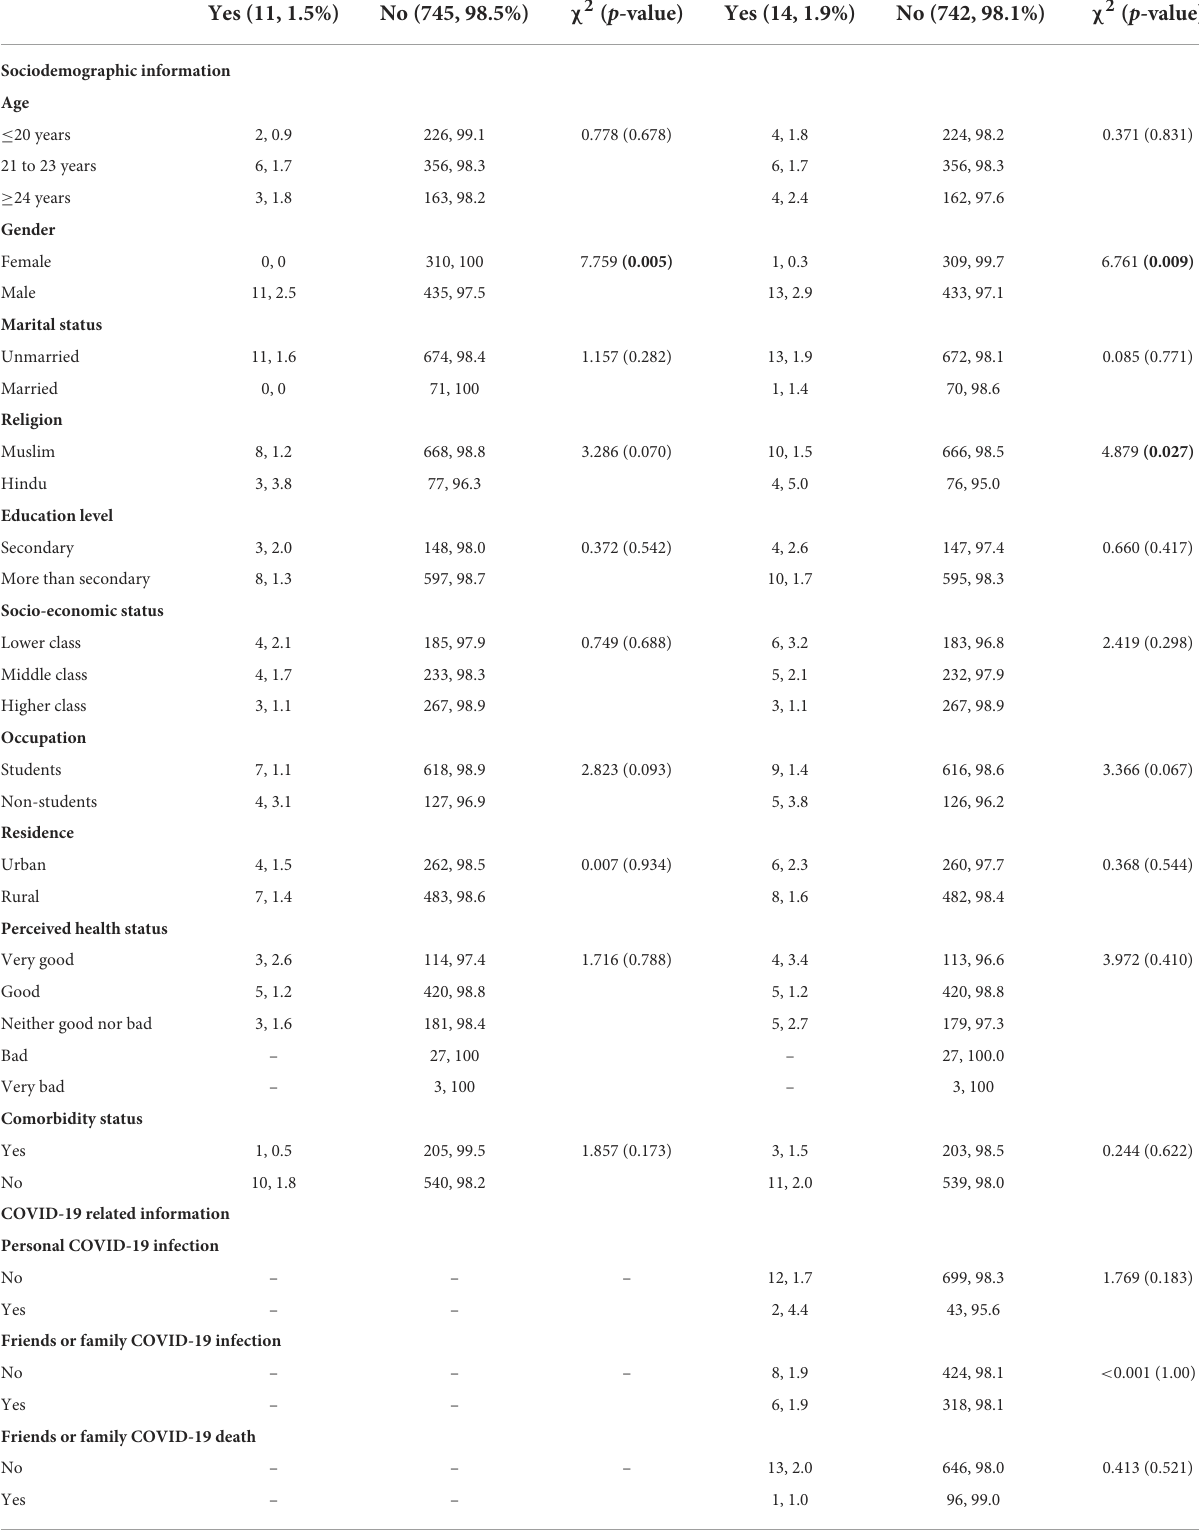
TABLE 3 Association between the independent variables and drug use.